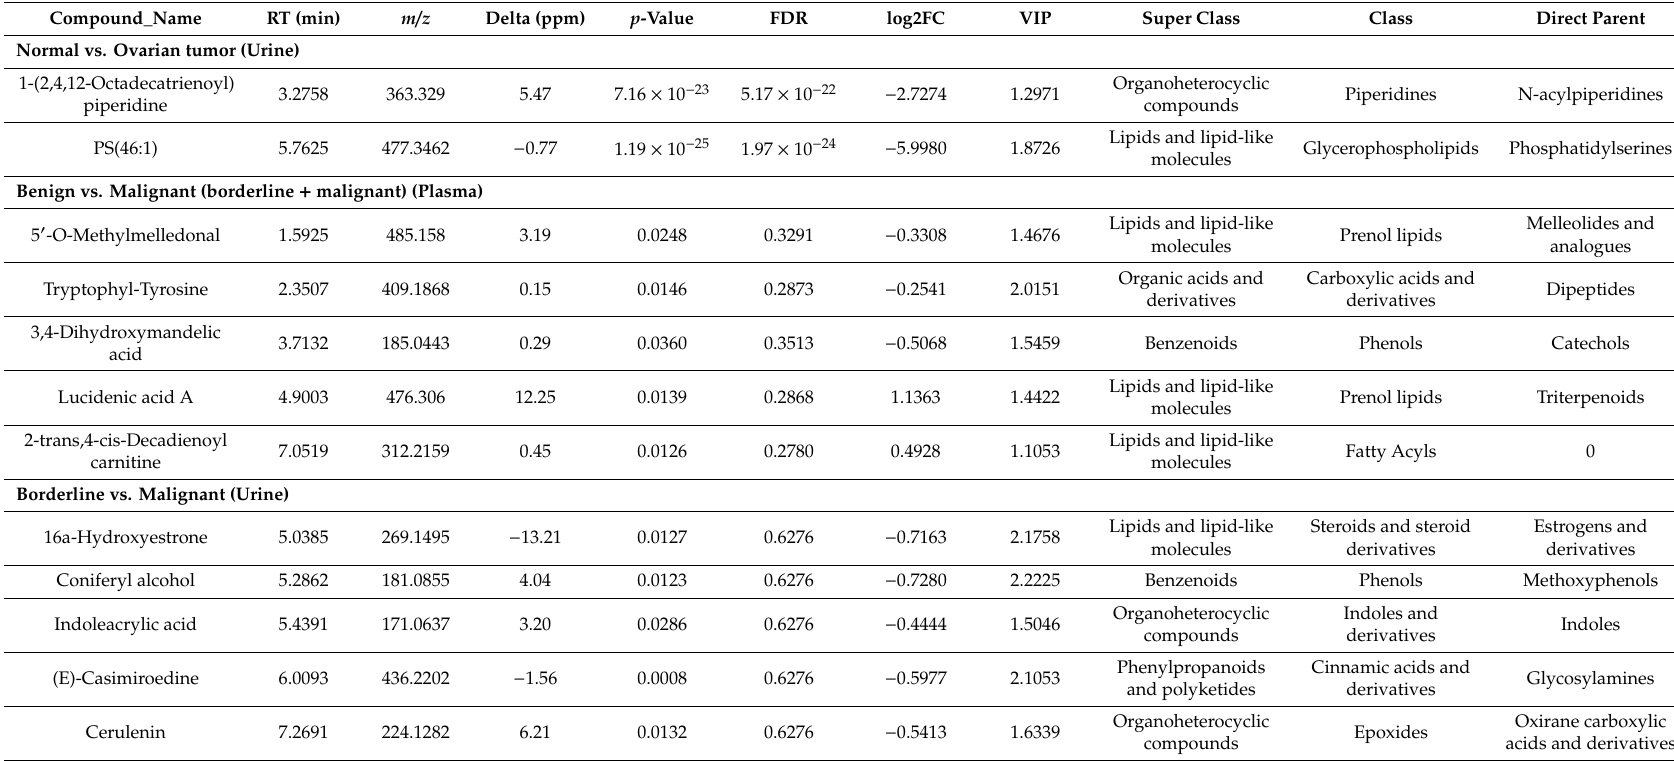
Table 2. The information of biomarker